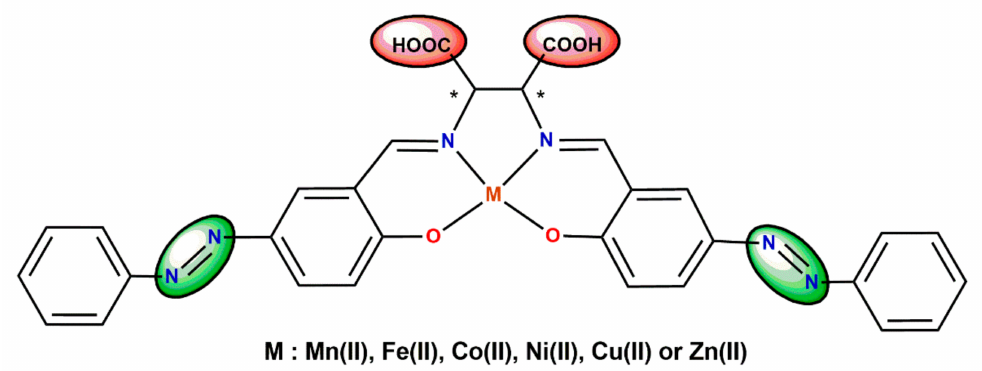
Figure 6. Salen-type transition metal complexes incorporating azo group (* denotes an asymmetric carbon atom)